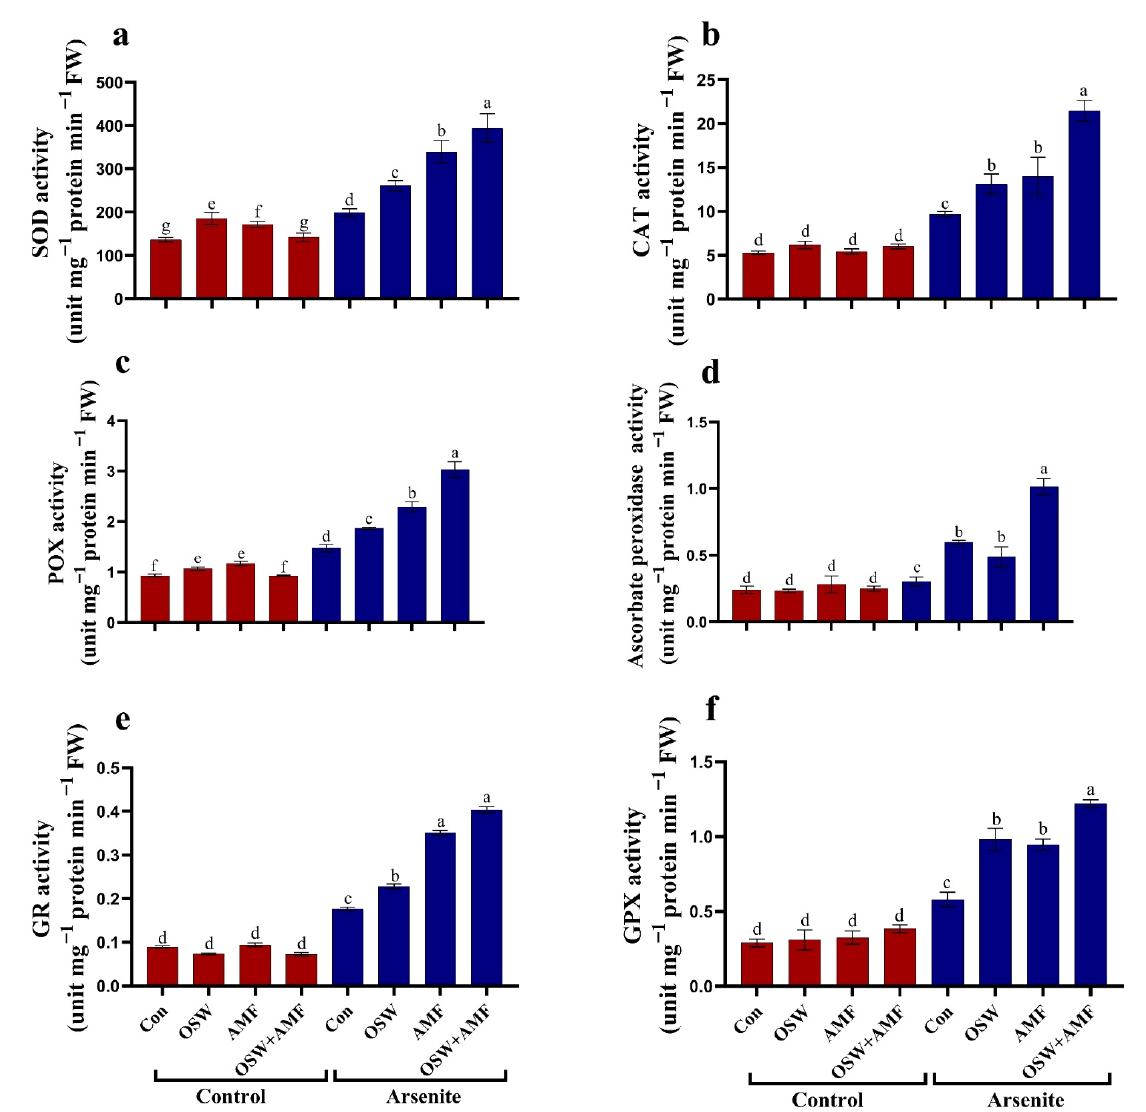
Figure 6. The influence of olive solid waste (OSW) and arbuscular mycorrhizal fungi (AMF), com- bination (OSW + AMF) on SOD ( a ), CAT ( b ), POX ( c ), ASC peroxidase ( d ), GR ( e ), and GPX ( f ) in wheat plants growing under As stress. Fishers test at p < 0.05 reveals significant variations in means ( ± standard deviation), which are different letters on the same bars.